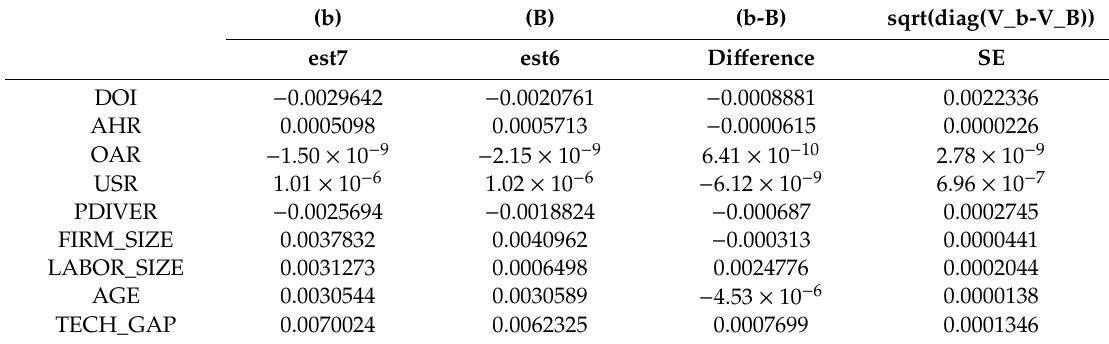
Table A2. Hausman